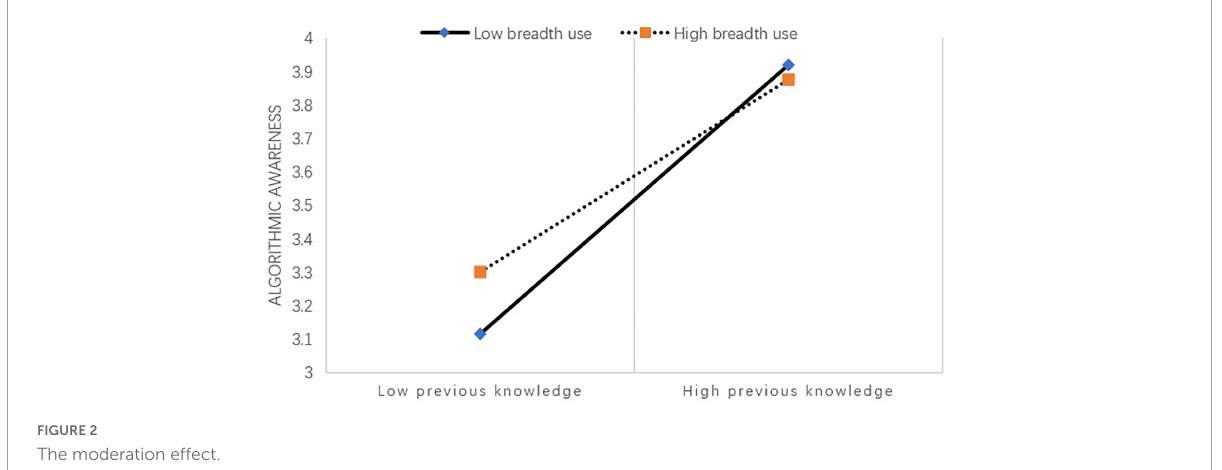
FIGURE2 The moderation